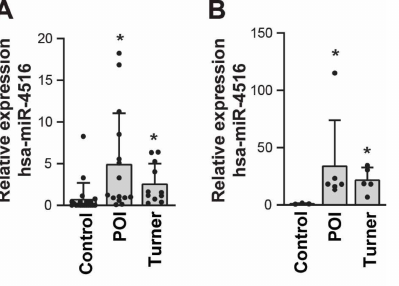
Figure 3. Relative expression of hsa-miR-4516 in the validation cohorts. ( A ) Relative expression of hsa-miR-4516 in the validation cohort, using qRT-PCR (patients with premature ovarian insufficiency (POI) = 15, patients with Turner syndrome = 11, and control individuals = 20). Relative miRNA expression was normalized by using UniSp6 as an internal control. ( B ) Relative expression of hsa-miR- 4516, using real-time Taqman analysis, was normalized by ath-miR-159a as an endogenous control (patients with premature ovarian insufficiency (POI) = 6, patients with Turner syndrome = 5, and control individuals = 3). The p -value was evaluated by comparison to the control group. Asterisks (*) indicate significant differences ( p < 0.05) when compared to the control